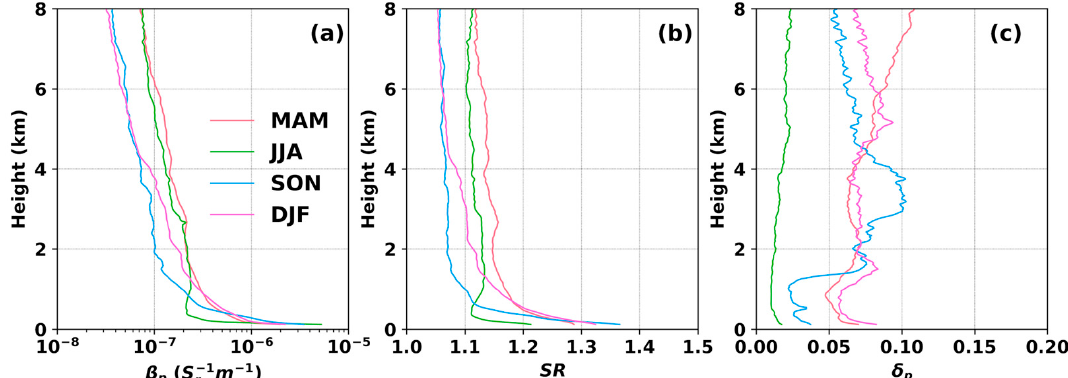
Figure 8. seasonal mean profiles of ( a ) 𝛽 (cid:3043) ; ( b ) SR ; ( c ) 𝛿 (cid:3043) . MAM (March-April-May) represents the Figure 8. Seasonal mean profiles of ( a ) β p ; ( b ) SR ; ( c ) δ p . MAM (March-April-May) represents spring season, JJA (June-July-August) for summer, SON (September-October-November) for fall, and DJF (December-January-February) for winter.